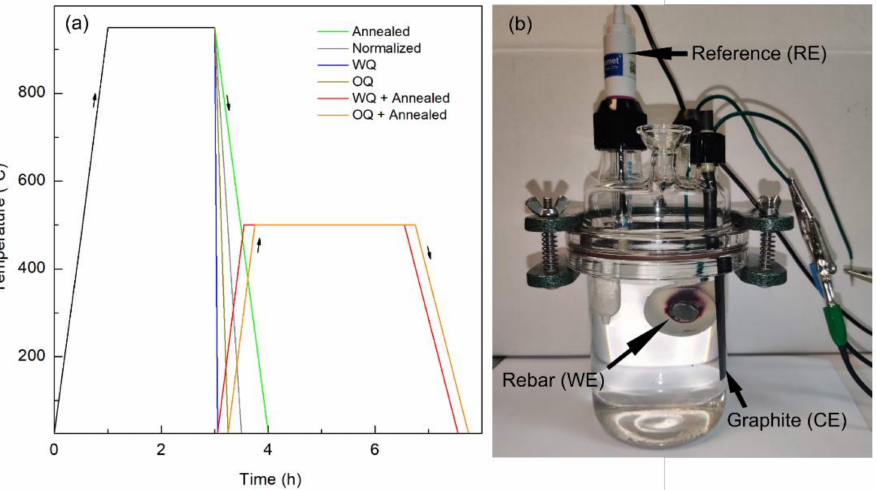
Figure 1. Setup used for the study: ( a ) thermomechanical treatment schematic, and ( b ) electrochemi- cal